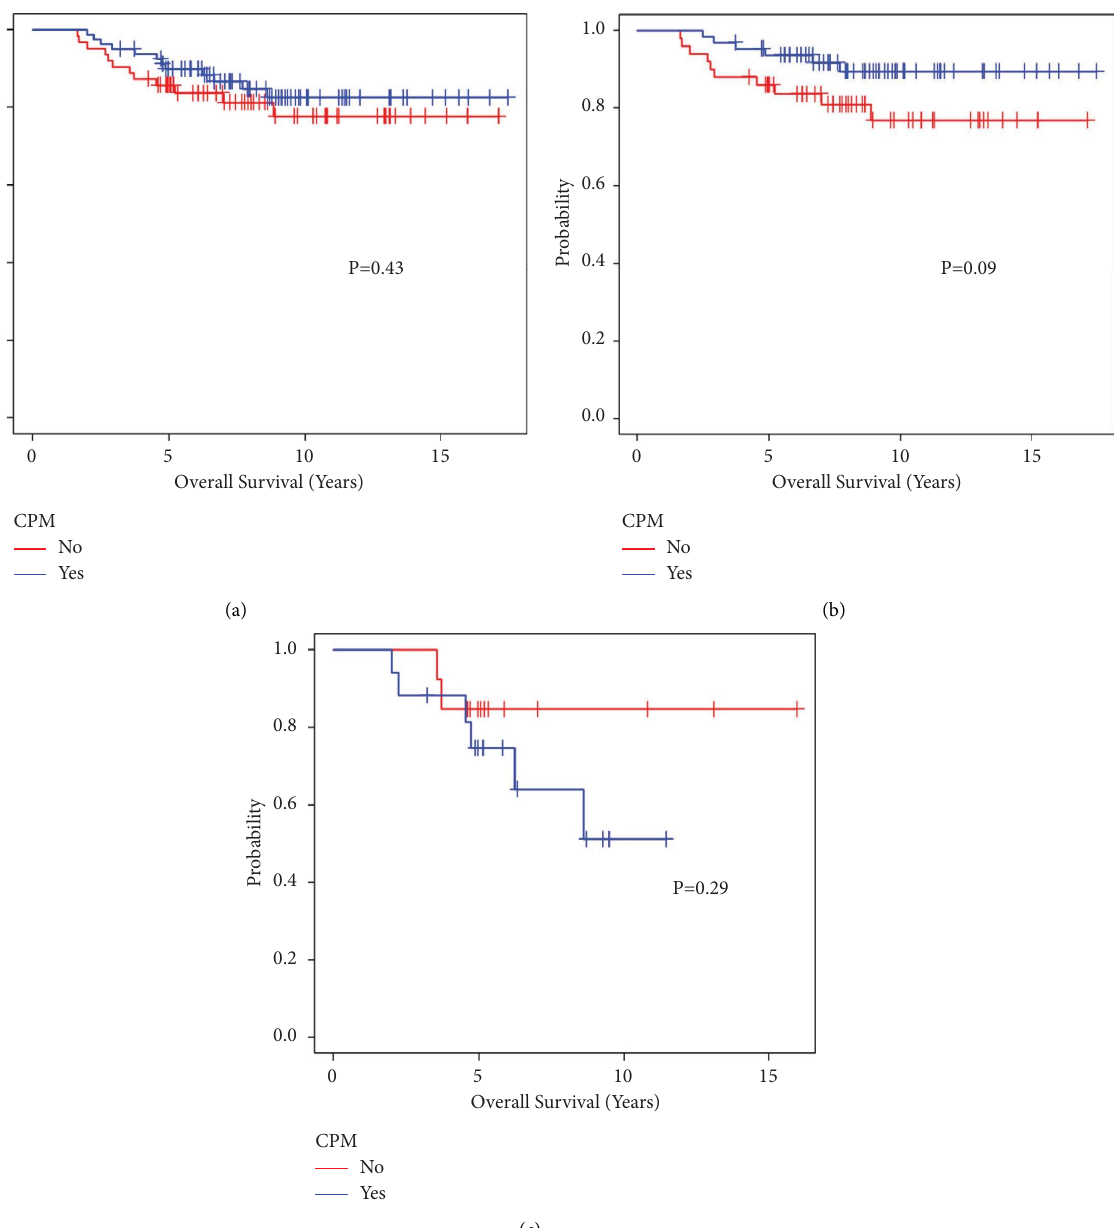
Figure 2: Overall survival comparing (a) patients by contralateral prophylactic mastectomy election and stratifcations for (b) white patients and (c) nonwhite